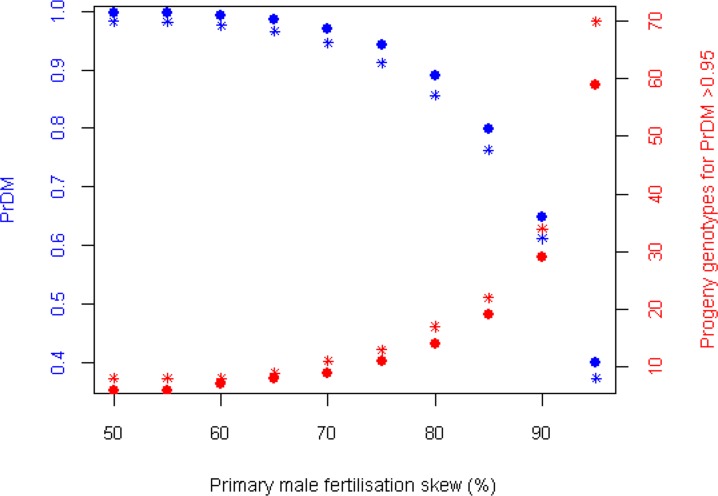
PrDM with skewed male fertilisation success.Variation in PrDM from 10 progeny genotypes (blue axis and data points) and the number of progeny genotypes required to achieve a 95% confidence level in PrDM (red axis and data points) under various scenarios of male fertilisation skew. Round points infer progeny genotyping at all 13 loci, while starred points infer progeny genotyping at only the three most informative loci (all amplified within Multiplex 4).